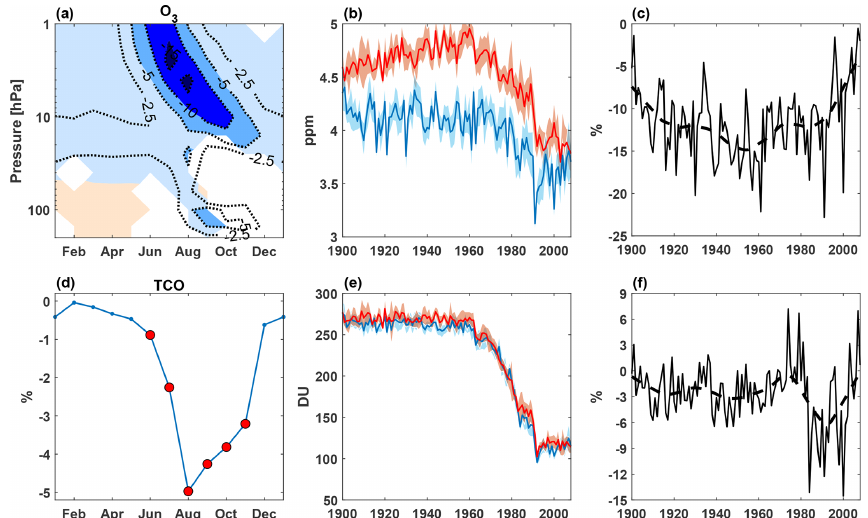
Figure 9. (a) Relative difference (EXP − REF) / REF in the monthly zonal mean polar ozone (70–90 ◦ S, 1–200hPa) during 1979–2008. Negative contour levels (dotted lines) are − 2 . 5%, − 5%, − 10% and − 15%. Colour shading indicates areas significant at the 95% level, calculated with a Monte Carlo simulation and a false detection rate. (b) September–October ensemble mean time series of polar ozone (70– 90 ◦ S, 10–20hPa) in EXP (blue) and REF (red). Shaded light blue and red areas represent 95% confidence intervals of ensemble means. (c) Relative difference of EXP and REF (solid line) and 31-year smooth trend (dotted line). (d) Relative effect of EPP on polar total column ozone (TCO). Red circles represent months with significant differences at the 95% level, calculated with a Monte Carlo simulation and a false detection rate. (e, f) This is the same for TCO as (b) and (c) ,